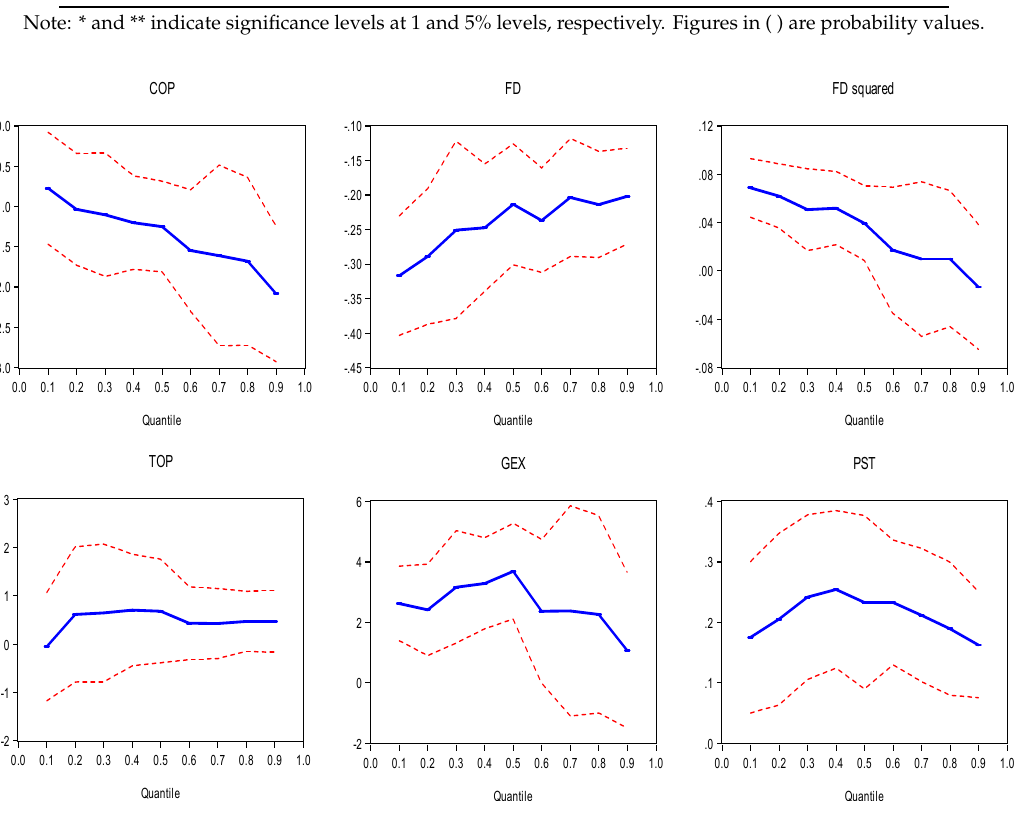
Figure 2. Changes in the quantile regression coefficient. Note: The upper and lower red lines represent the corresponding Ordinary Least Square (OLS) estimates with a 95% confidence interval, which indicates the degree of influence of the factors on the per capita income under different quantiles.